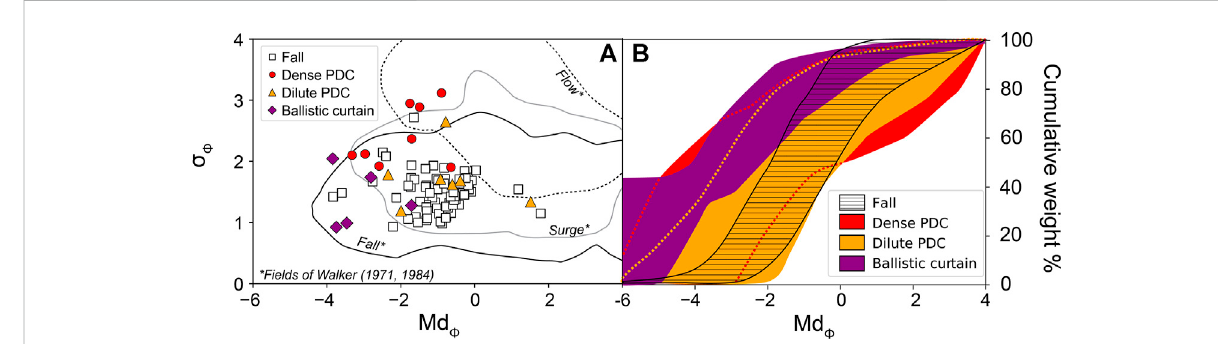
FIGURE 3 (A) Median clast size and sorting parameters for all sampled deposits categorized by mechanism of formation. Pyroclastic deposit fi elds of Walker(1971,1984)areoverlainon (A) ,with ‘ surge ’ beingroughlyequivalenttodilutePDCs. (B) showsthecumulativeweightpercentcurvesforClear Lake deposits based on their interpreted mechanism of formation. Note that many of these fi elds overlap due to both shared grain-size characteristics of the deposits; the presence of volcanic bombs in some layers may also skew